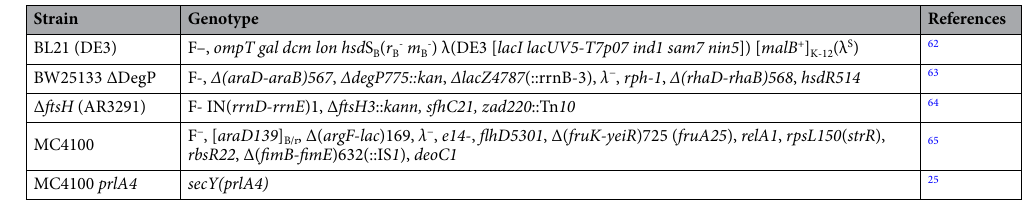
Table 1. Escherichia coli strains used for expression/translocation